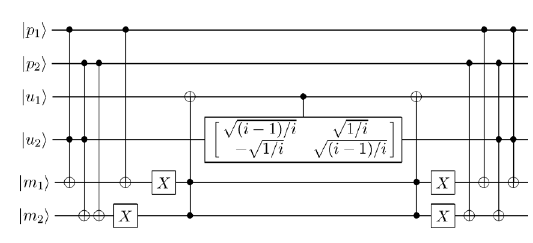
Figure 1. The quantum circuit implementing an iteration encoding a 2-bit pattern in the Trugenberger’s approach. Qubits p are used as temporary storage